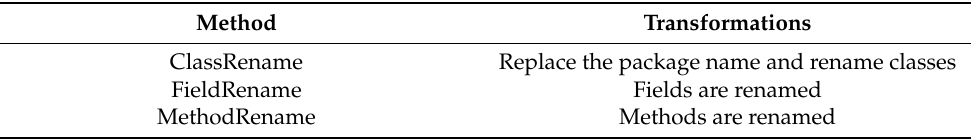
Table 2. Non-Trivial Obfuscation Techniques–Rename.